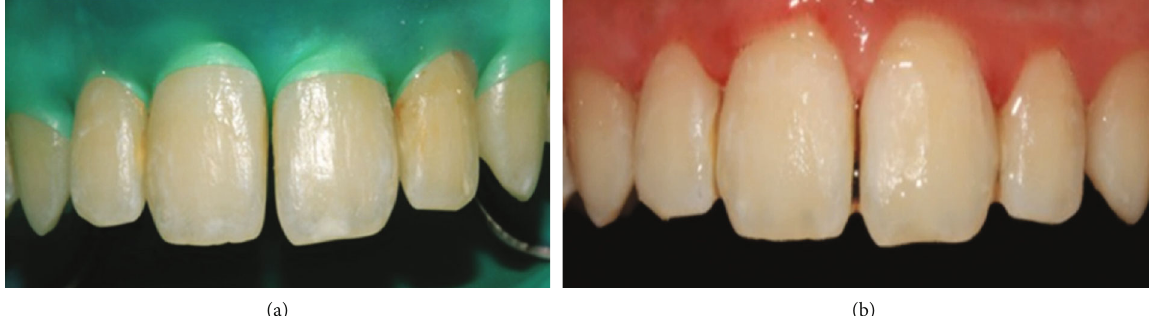
Figure 1: (a) Case 1, pretreatment. (b) Post-treatment with resin in fi ltration.